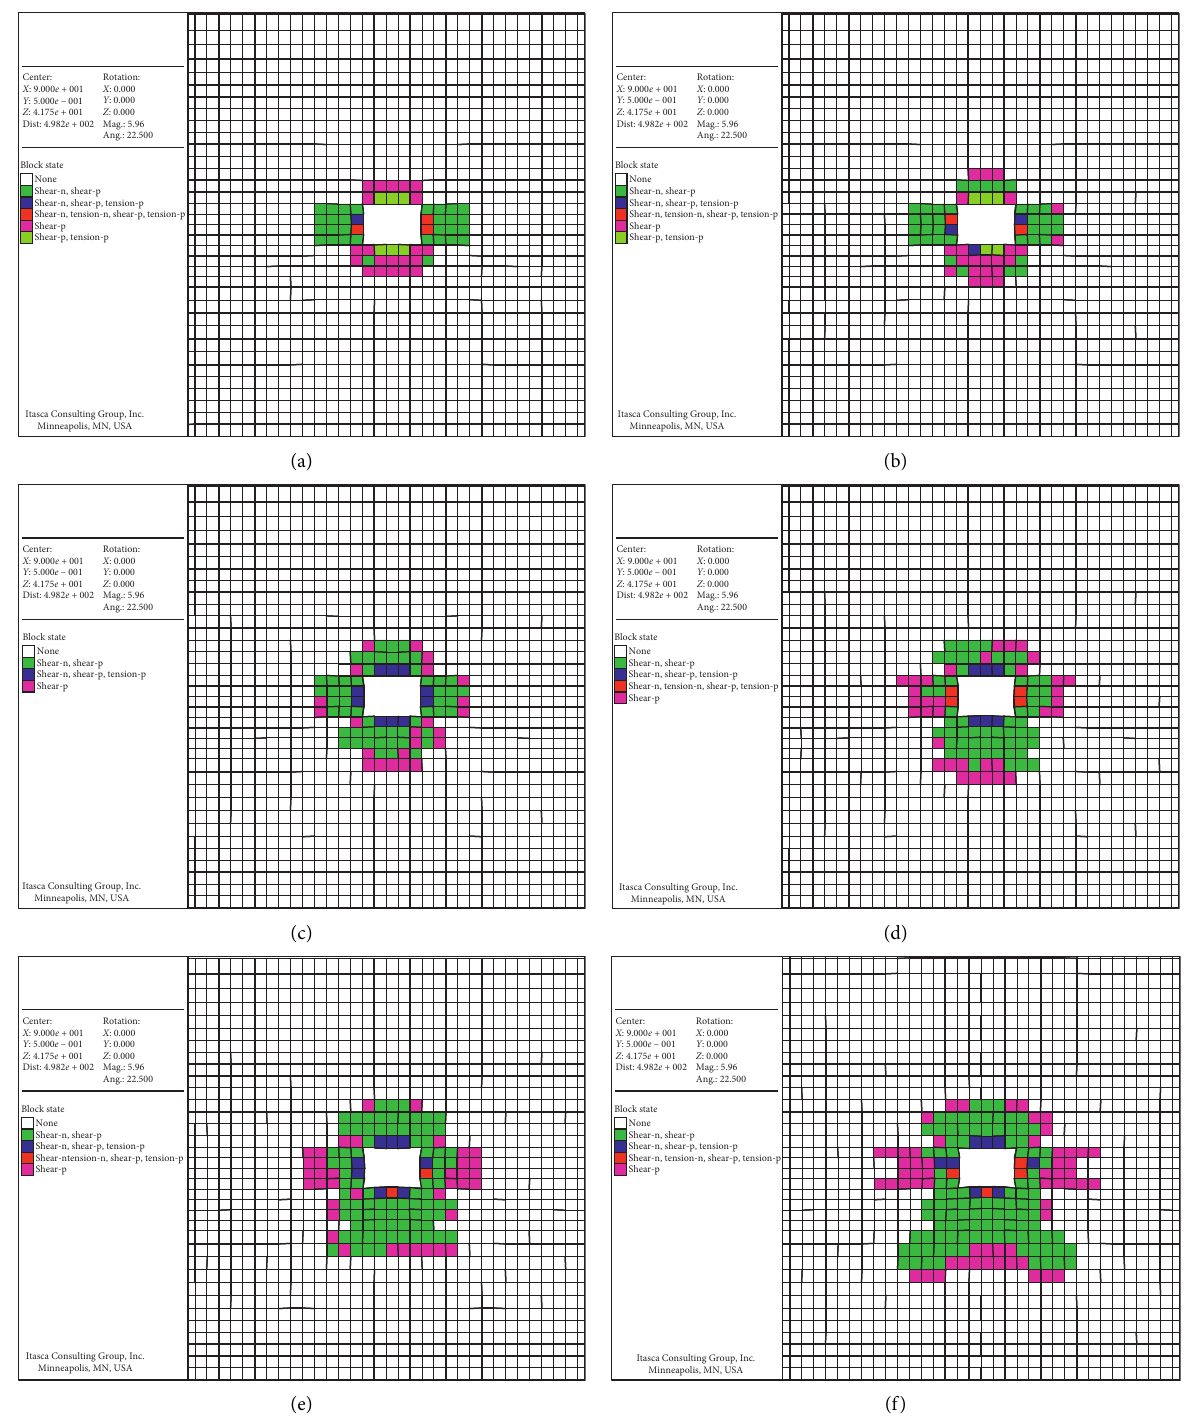
Figure 15: The plastic zone distribution of the roadway. (a) λ � 1.0; (b) λ � 1.2; (c) λ � 1.4; (d) λ � 1.6; (e) λ � 1.8; and (f) λ �